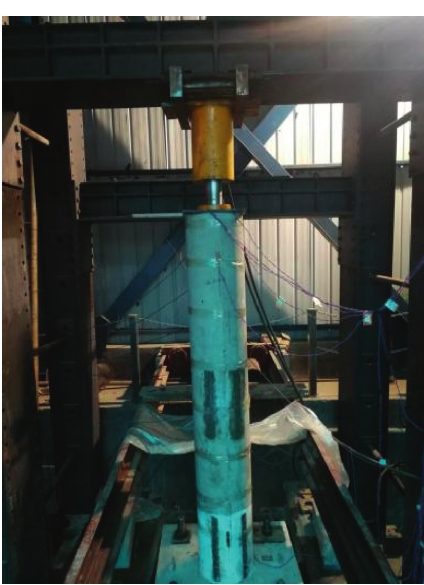
Figure 8: Impacted specimen and constraints.